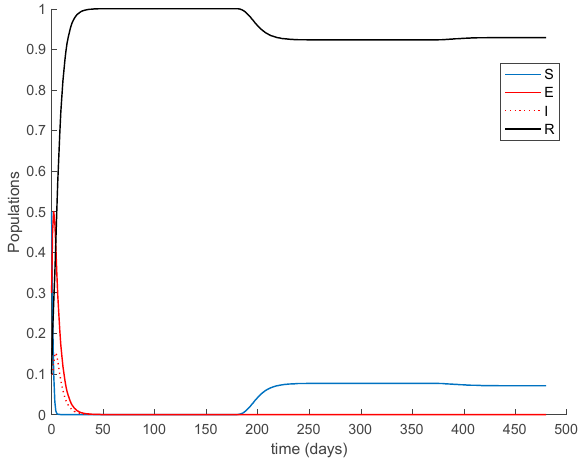
Figure 11. Global asymptotical stability of the endemic equilibrium point for Case 1.6 conditions. = , and a constant loss of immunity with de- Case 1.7. The vaccination gain is 10 .K df